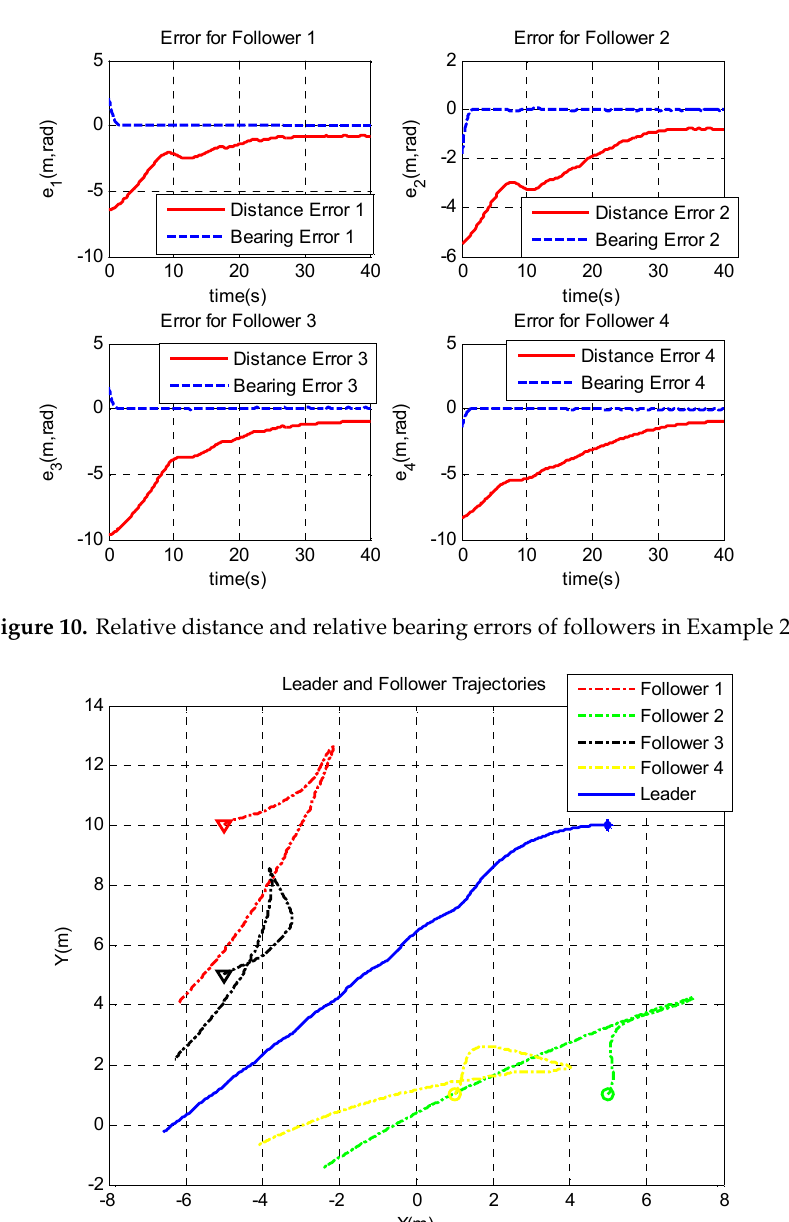
Figure 12. Applied input control of the first follower in Example 2.